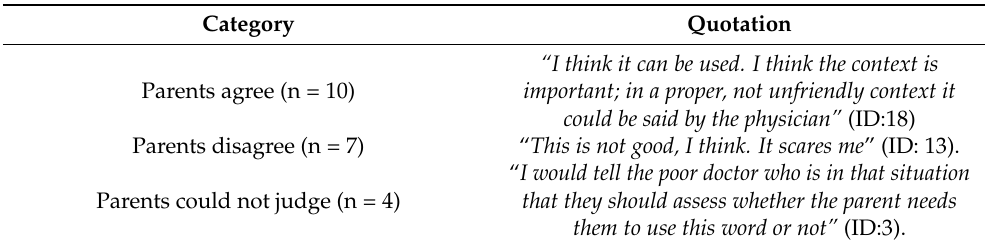
Table 5. Categories and quotations of Code 2.4 (parents’ opinions on the use of the word “death”: